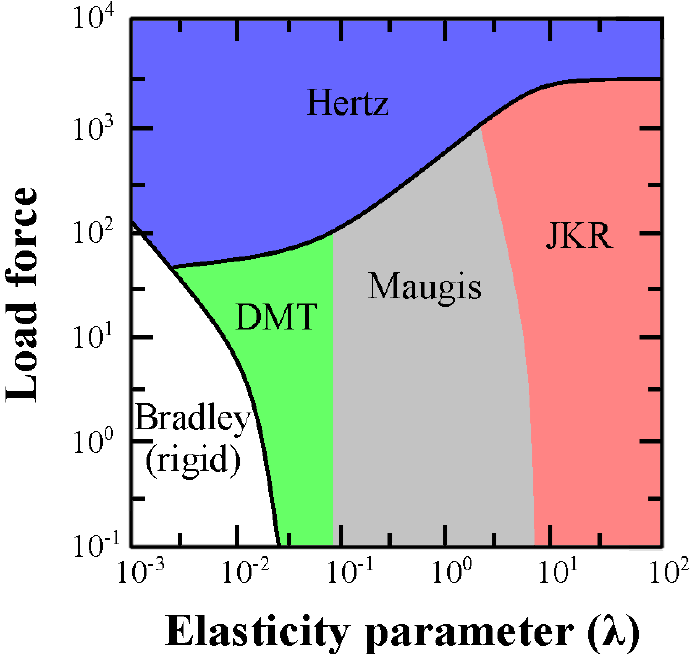
Figure 2 . Map of the elastic behavior of matter according on the load force and λ parameter. In case of negligible adhesion, deformation falls in the Hertz limit. The DMT and JKR models are suitable for those samples that experiment small deformations or high adhesions, respectively. The Maugis theory is valid for the boundary region between the DMT and JKR